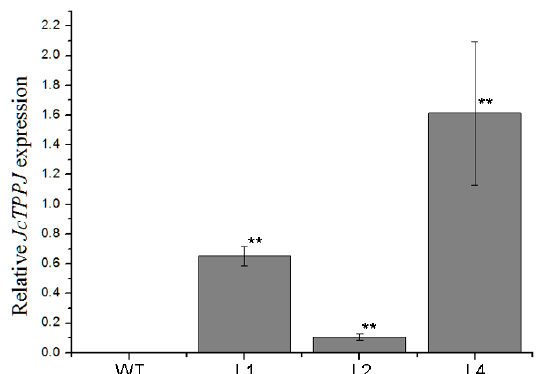
Figure 3. Relative expression levels of JcTPPJ in wild ‐ type (WT) and different transgenic Arabidopsis lines (L1, L2, and L4). The qRT ‐ PCR results were obtained from three independent biological replicates per sample. The amplification levels were normalized using the amplified products of the AtActin2 gene as a reference. ** indicates a significant difference at the p < 0.01 level determined by one ‐ way ANOVA. The error bars represent the standard errors ( n = 3).